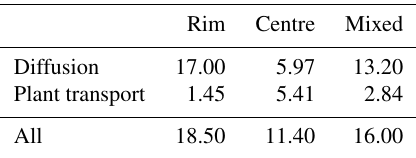
Table B1. Maximal values of the cumulative sums of modelled oxygen uptake over the modelled time period for rim, centre and a mixed approach of 65% rim plus 35% centre for the different transport processes and combined in kg O 2 m − 2 , rounded to three non-zero